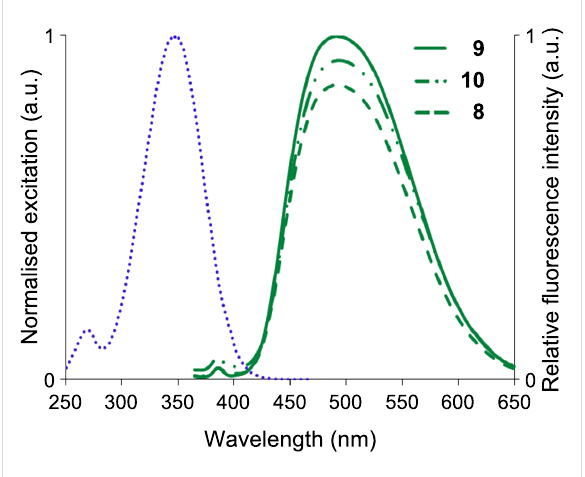
Figure 3: Excitation (left) and emission (right) spectra of compounds 8 – 10 in 1,4-dioxane (the excitation spectra of the 3 compounds are entirely